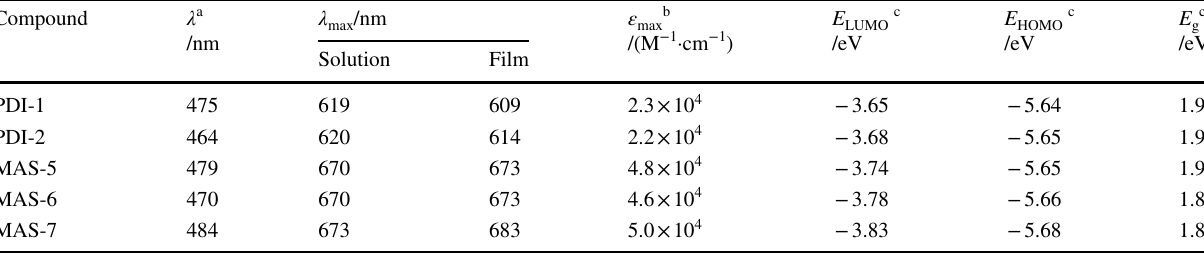
Table 1 Summary of photophysical and electrochemical properties of the NFAs